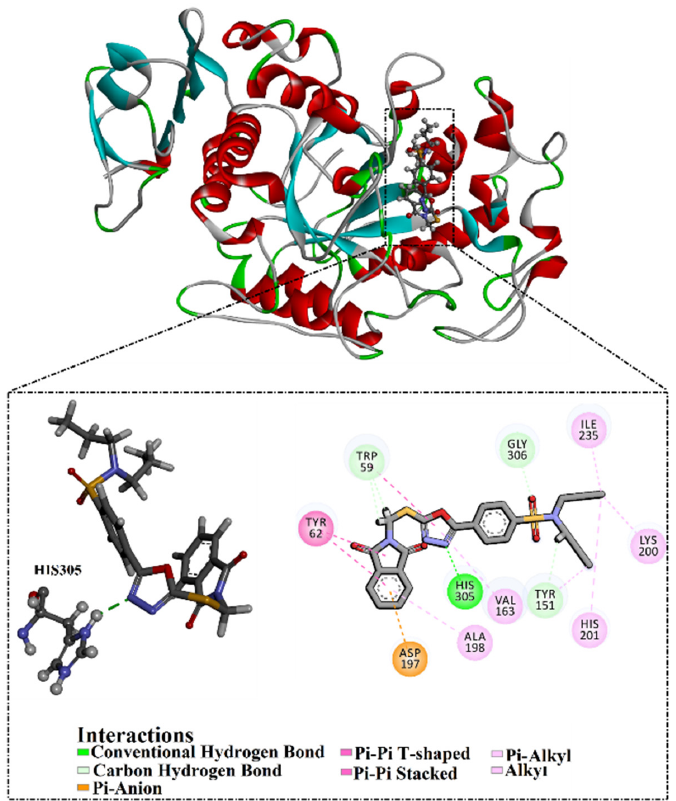
Figure 11. 3D and 2D molecular interactions of PESMP with proximal residues of α -amylase en- zyme.